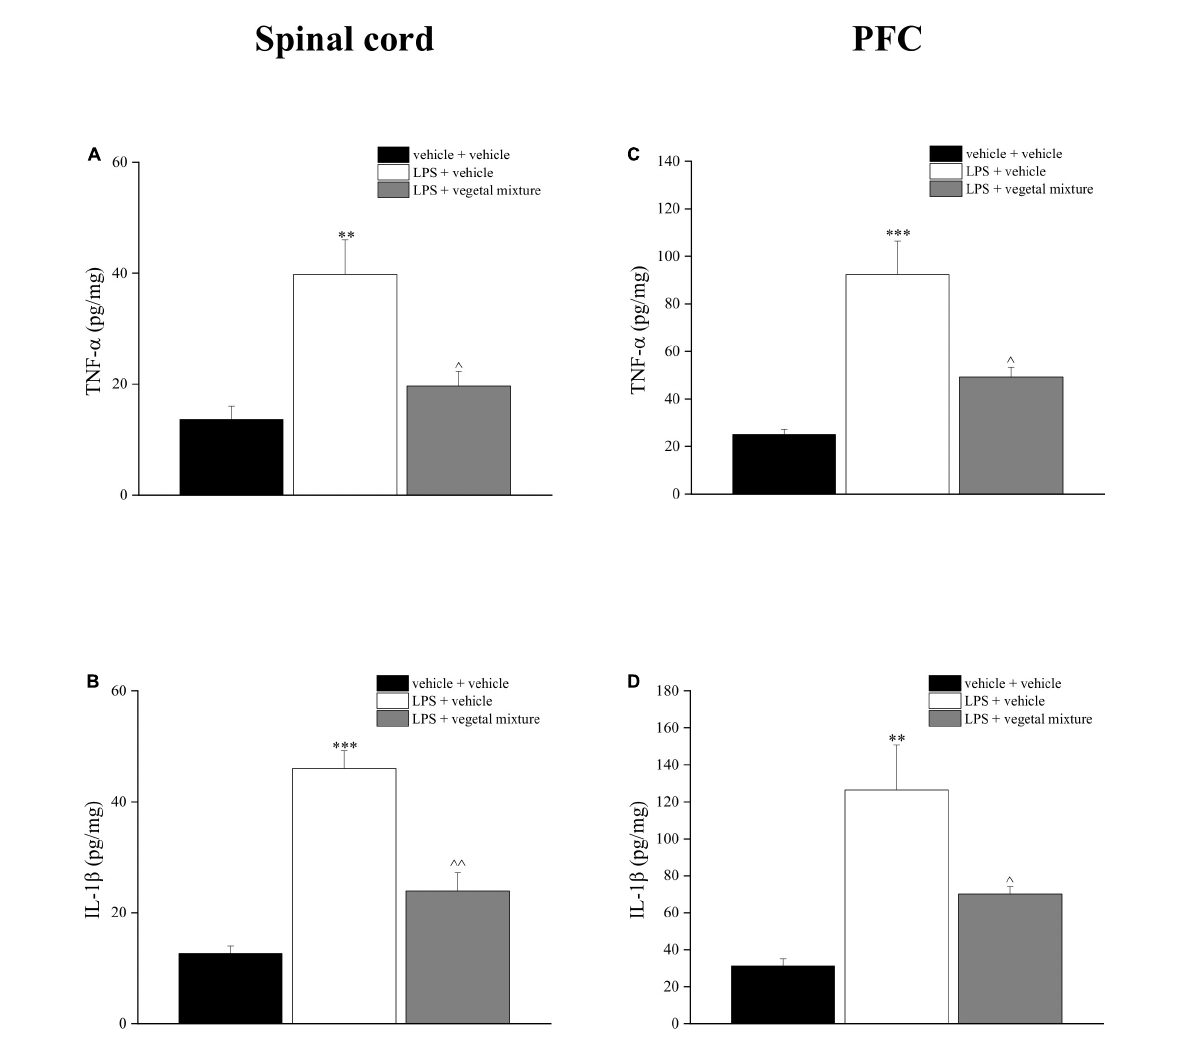
FIGURE10 Effect of a vegetal mixture on LPS-induced overproduction of TNF- α and IL-1 β levels in the prefrontal cortex and spinal cord. LPS (1 mg kg - 1 ) was intraperitoneally injected on days 1, 3, 5, and 8. The vegetal mixture was composed of Zingiber officinale (150 mg kg - 1 ), Echinacea purpurea (20 mg kg - 1 ), and Centella asiatica (200 mg kg - 1 ), suspended in 1% carboxymethylcellulose sodium salt (CMC) and orally administered daily starting from day 1 till the end of the experiment. Control animals were treated with vehicles. At the end of the behavioral experiments and 24 h after the last administration of the vegetal mixture, animals were sacrificed and the prefrontal cortex and the lumbar spinal cord were collected. (A) TNF- α and (B) IL-1 β concentrations in the spinal cord of vehicle-treated, LPS-treated, and LPS + vegetal mixture-treated mice. (C) TNF- α and (D) IL-1 β concentrations in the PFC of vehicle-treated, LPS-treated, and LPS + vegetal mixture-treated mice. Data are expressed as mean ± SEM of eight mice analyzed in two different experimental sets. ∗∗ p < 0.01 and ∗∗∗ p < 0.001 vs. vehicle-treated mice; ∧ p < 0.05 and ∧∧ p < 0.01 vs. LPS-treated